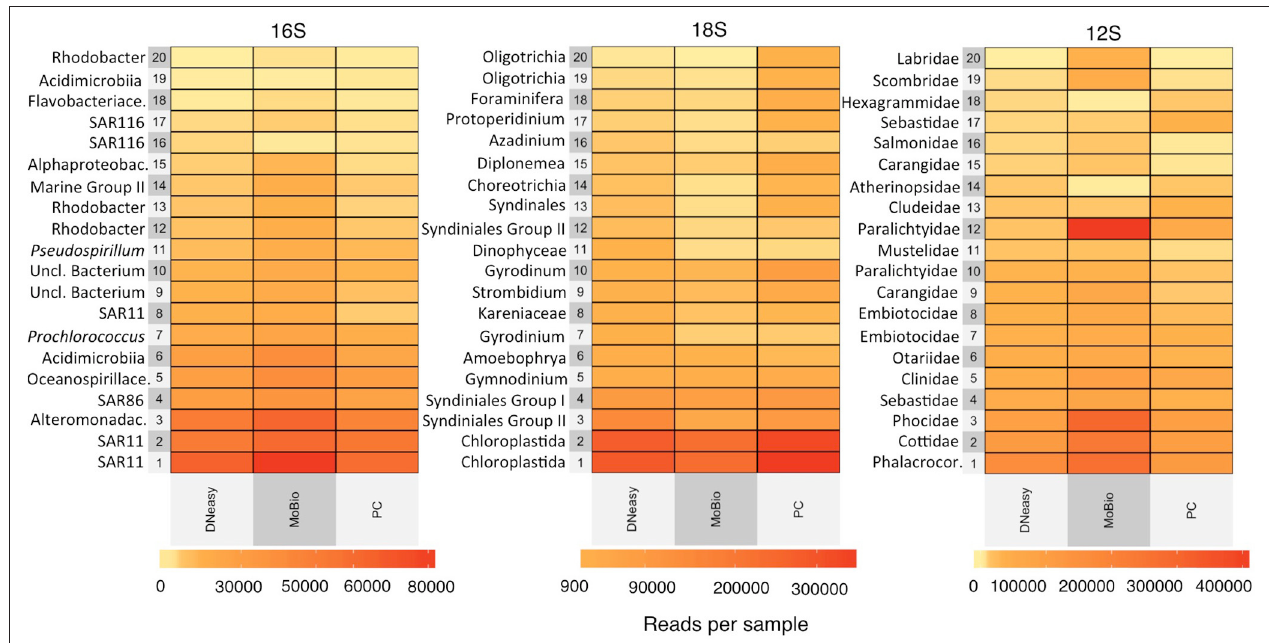
FIGURE 4 | Differences in the top 20 most abundant OTUs obtained overall from the 16S rRNA gene, the 18S rRNA gene, and the 12S rRNA gene metabarcoding showing their relative abundance with the three different extraction methods [DNeasy Blood and Tissue Kit (DNeasy), MoBio PowerWater DNA Isolation Kit (MoBio), and phenol/chloroform (Ph-Ch)]. The relative abundance was calculated for all data (all filters combined) per extraction method. The taxonomy of the 20 most abundant OTUs visualized in the heatmap are specified on y-axis of each figure. The ranks are listed to the lowest taxonomic resolution